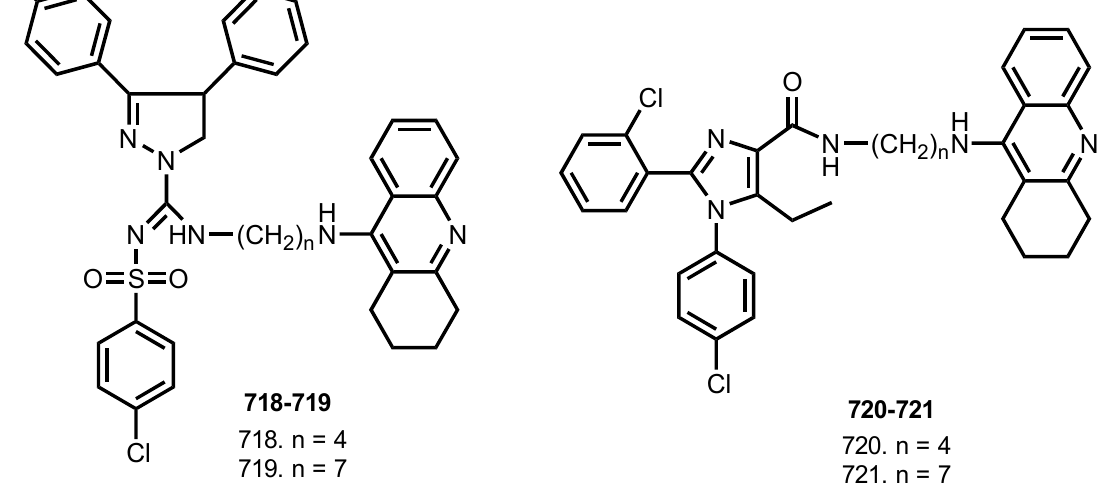
Figure 28. AChEIs/CB1 receptor antagonists 718 – 721 [107].